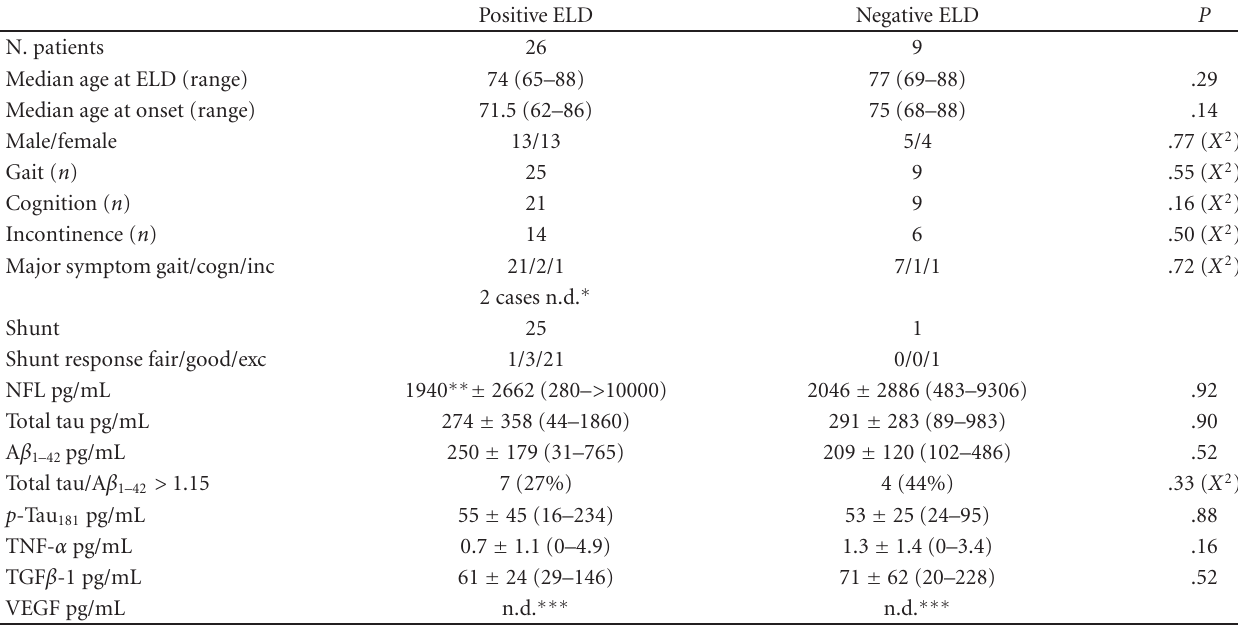
Table 1: Characteristics of the patients and CSF concentrations of the analyzed biomarkers.